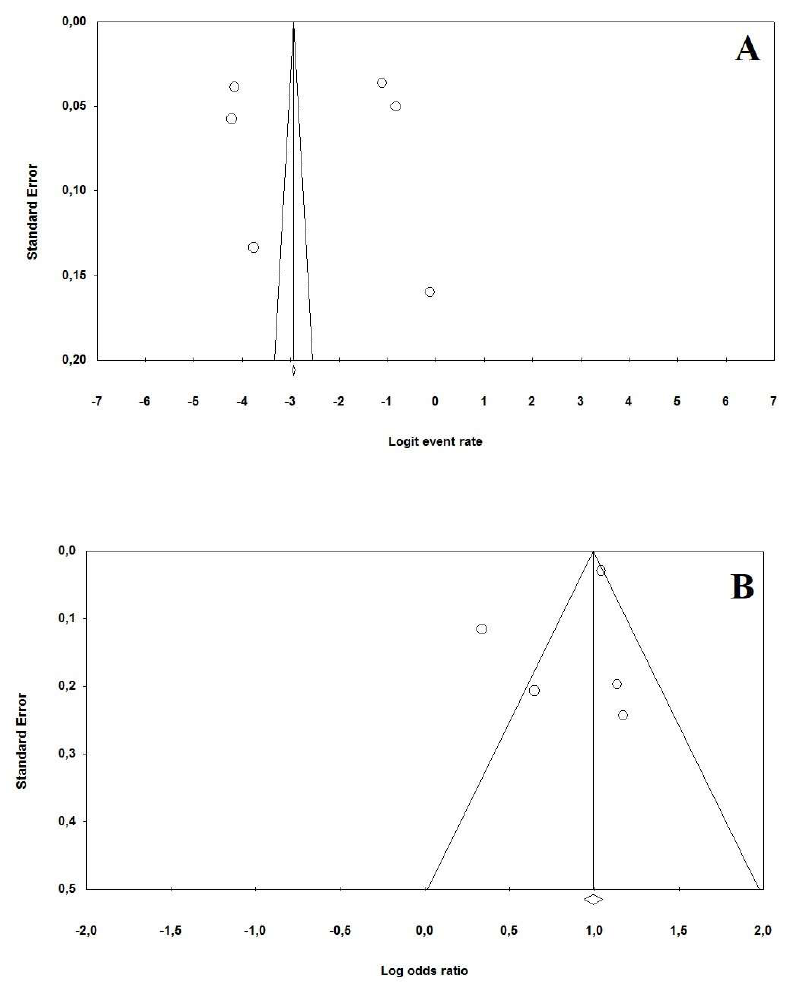
Figure 3. Funnel plots for ( A ) the polled prevalence of metabolic syndrome in COVID-19 patients and ( B ) for the mortality risk due to metabolic syndrome in COVID-19 patients.